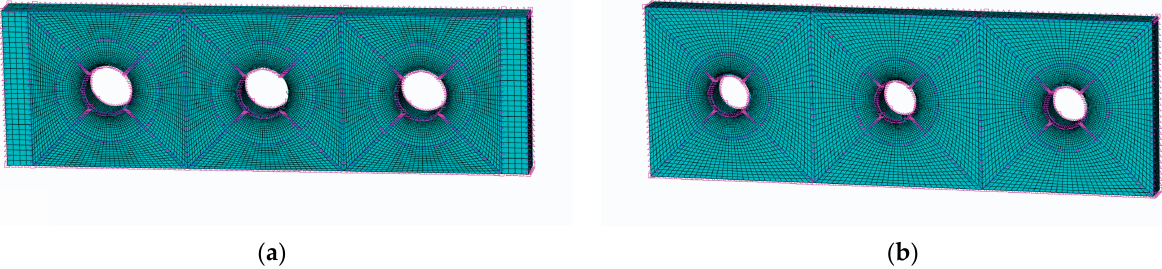
Figure 6. Mesh quality of three-hole specimen hole edge: ( a ) three times the hole diameter for the three-hole specimen; ( b ) four times the hole diameter for the three-hole specimen.